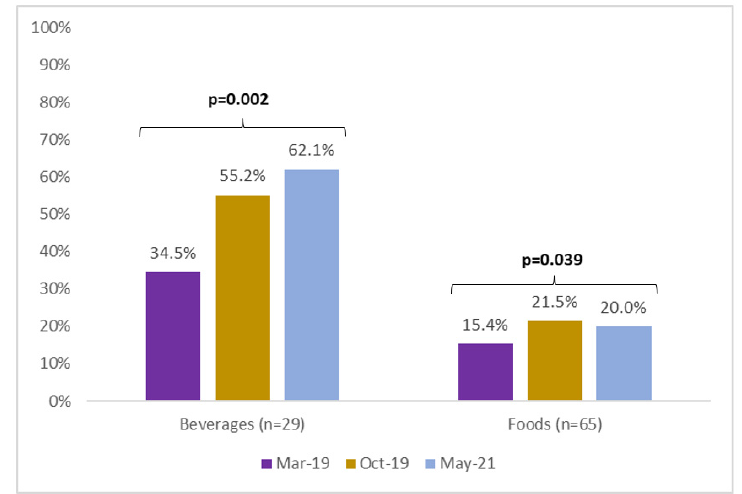
Figure 2. Percentage of beverages and foods using nonnutritive sweeteners (NNS) across time. Comparison of percentages of products using NNS was made using the Cochran test for three groups of paired data. Bold values represent p < 0.05.